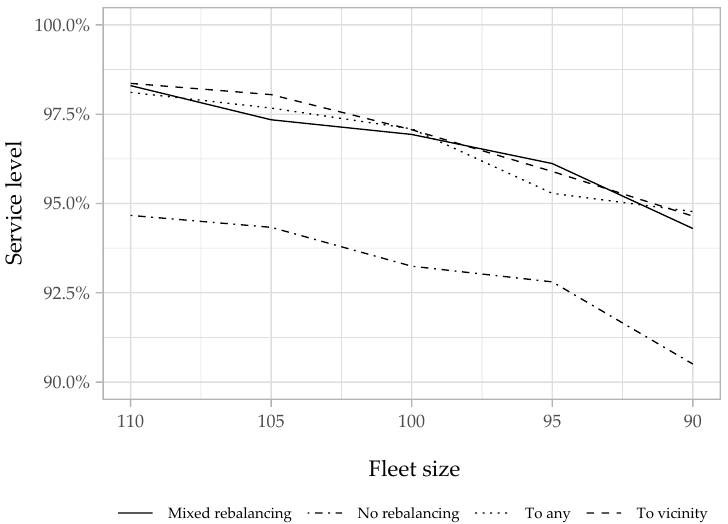
Figure 8. Variation in the service level according to the fleet size.